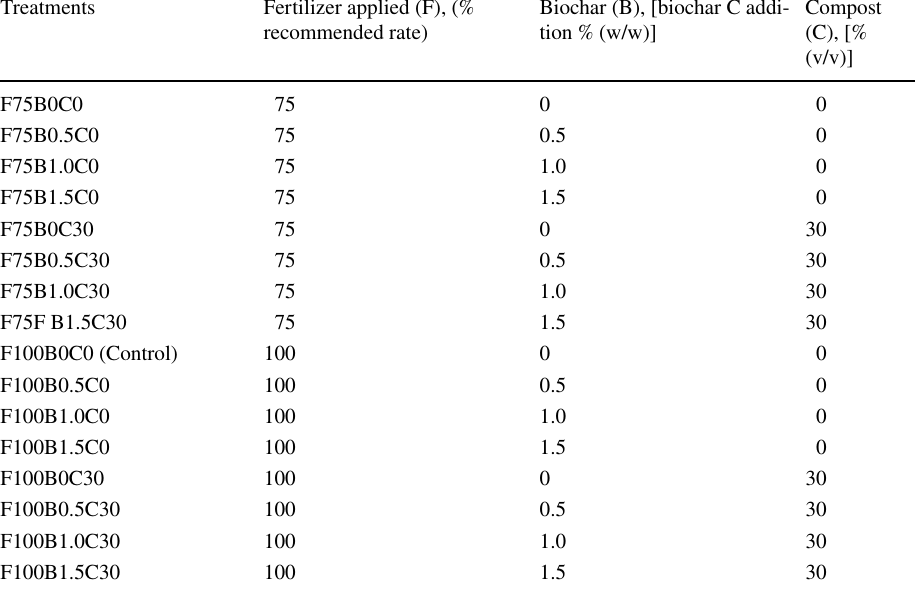
between fertiliser application rates (F), biochar (B) and compost (C)